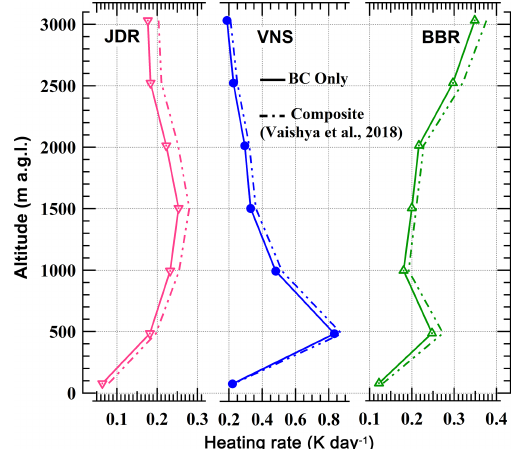
Figure 12. Vertical profiles of atmospheric heating rate due to BC (solid lines) and composite (dashed lines) aerosols for the regions of the IGP: (a) JDR in western IGP, (b) VNS in central IGP and (c) BBR in eastern IGP. Data for the composite heating rate profiles are from Vaishya et al.